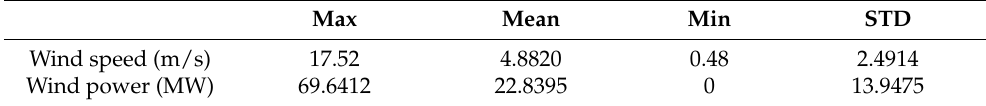
Table 1. Summary of the input data.